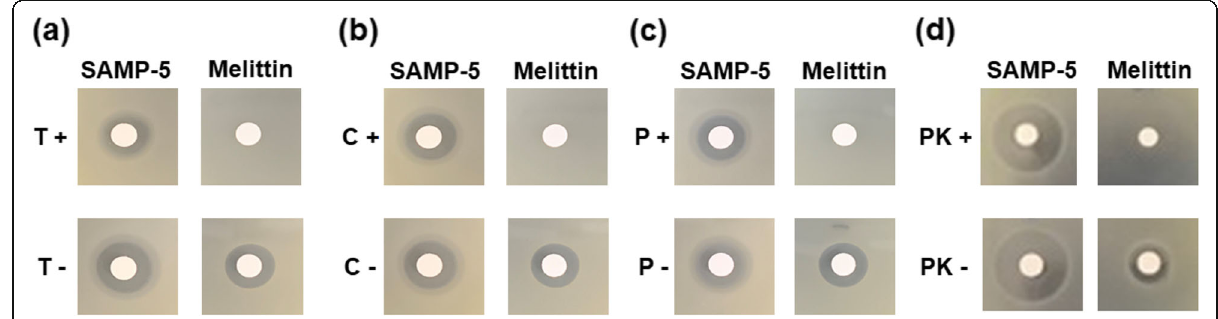
Fig. 3 Inhibition of antimicrobial activity of SAMP-5 and melittin by pepsin ( a ), trypsin ( b ), α -chymotrypsin ( c ), and proteinase K ( d ) as assessed by a radial diffusion assay using MDRPA (CCARM 2109). P, T, C, and PK represent pepsin, trypsin, α -chymotrypsin, and proteinase K,